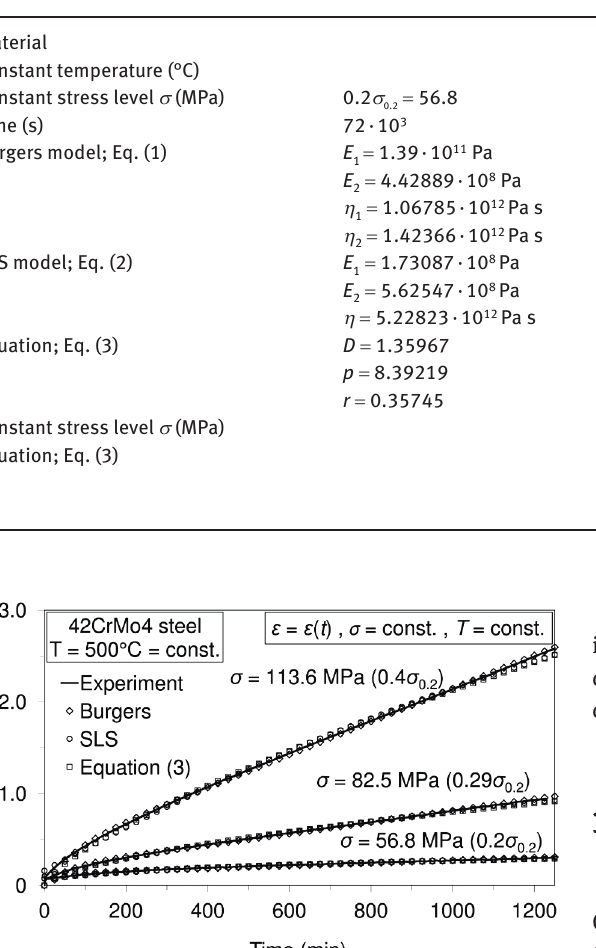
Table 2: Data of the modeling of creep